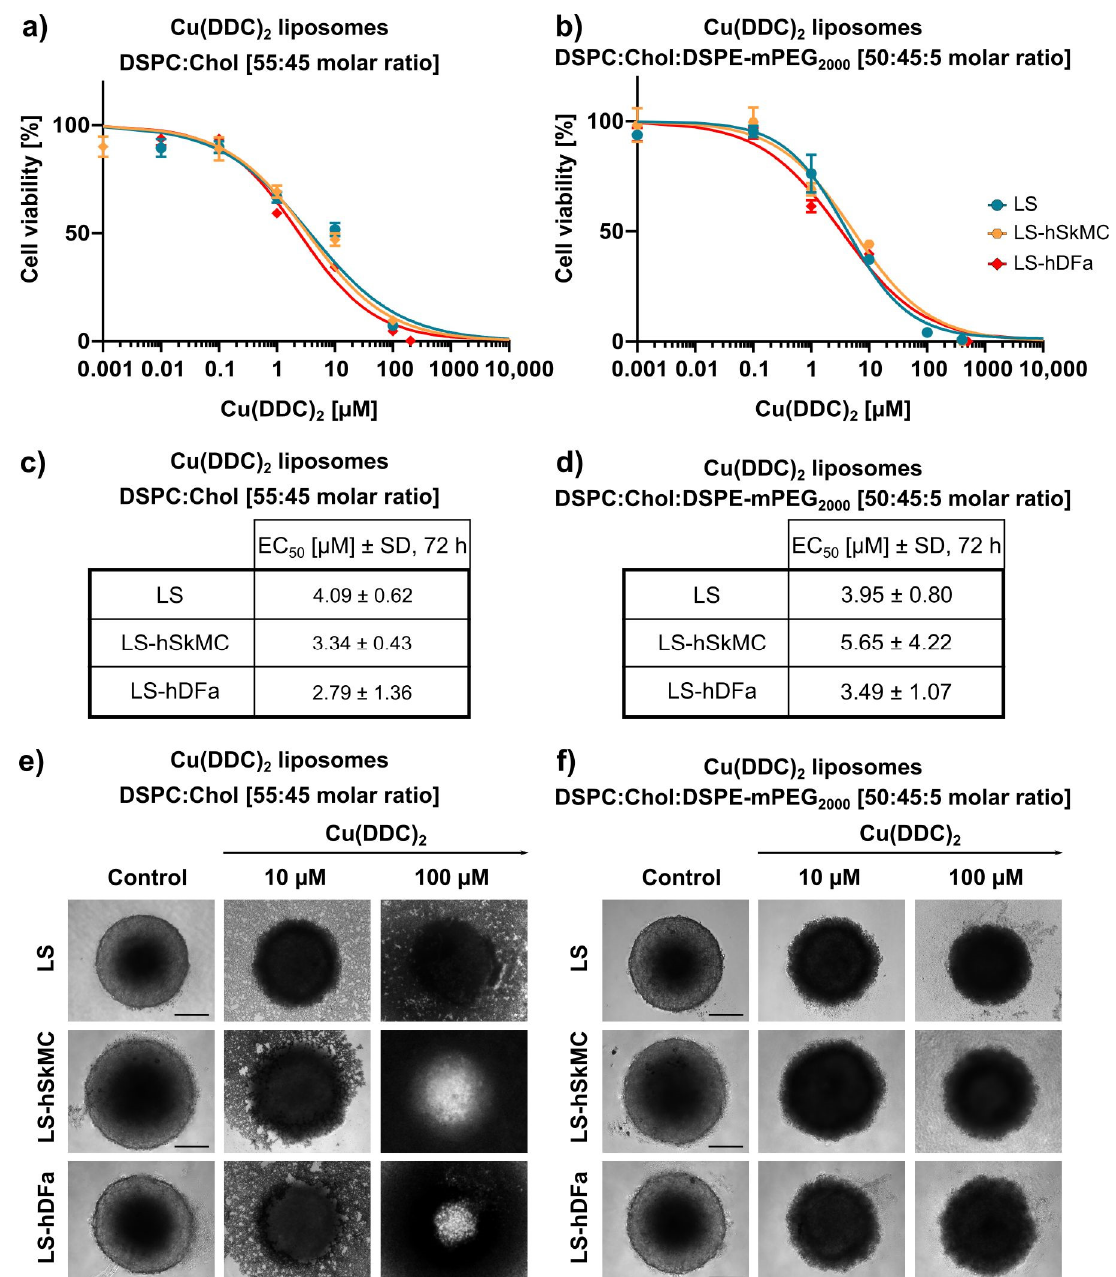
Figure 11. In vitro cytotoxicity of Cu(DDC) 2 liposomes on LS-hSkMC and LS-hDFa co-culture spheroids. ( a , b ) LS monoculture spheroids, LS-hSkMC and LS-hDFa co-culture spheroids were treated 72 h with non-PEGylated ( a ) and PEGylated ( b ) Cu(DDC) 2 liposomes. 3D spheroids were generated by using agarose-coated wells with subsequent centrifugation. hSkMC and hDFa cells are mixed with LS cells in a 1:1 ratio for co-culture spheroids, respectively. Cell viability curves were obtained using the 3D CellTiter-Glo ® assay after indicated treatment duration. ( c , d ) EC 50 values after 72 h of treatment with non-PEGylated ( c ) and PEGylated ( d ) Cu(DDC) 2 liposomes. Data are expressed as the mean ± SD ( n = 3). ( e , f ) Representative brightfield microscopy images of LS monoculture and co-culture spheroids with hSkMC and hDFa, respectively. Images were taken after 72 h of treatment with non-PEGylated ( e ) and PEGylated ( f ) Cu(DDC) 2 liposomes. Scale bar = 200 µm.